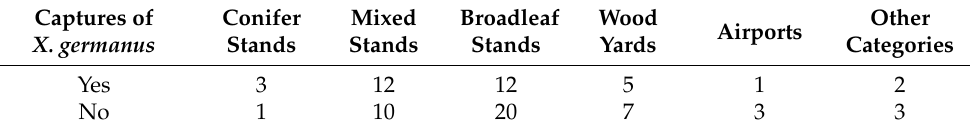
Table 4. Distribution of locations where kairomone traps for BSB were set up and the species’ presence detected.